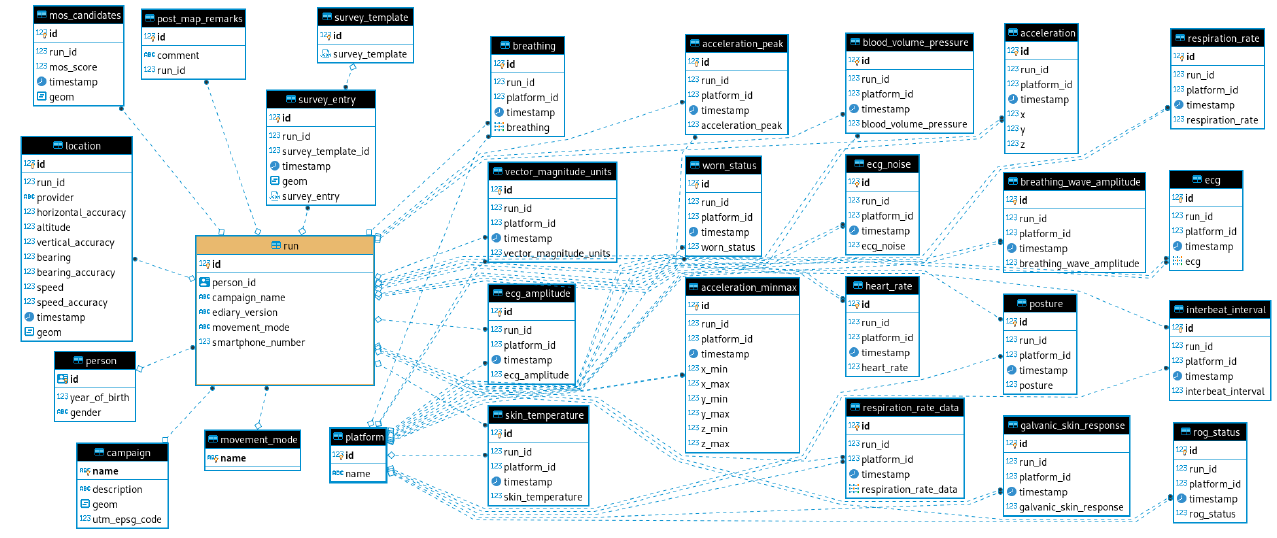
Figure 1. Entity relationship diagram SQLite database.